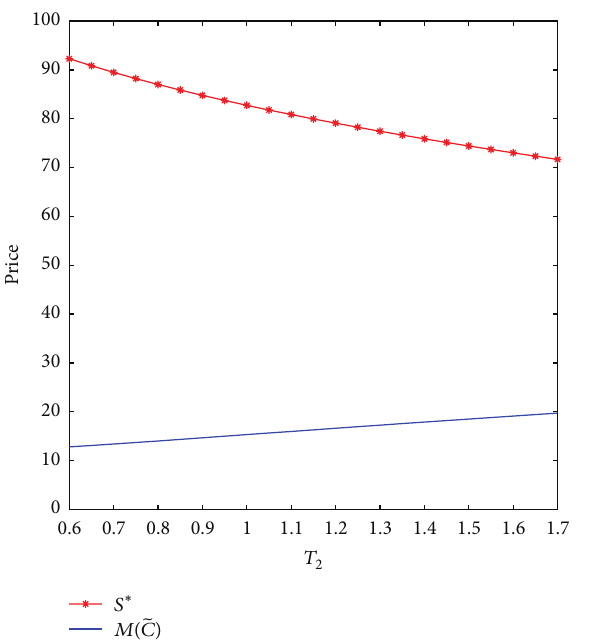
𝑀(̃𝐶) with respect to 𝑇 2 .